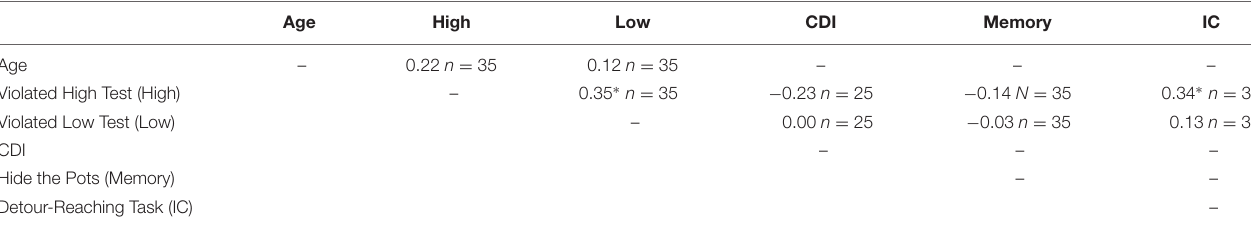
TABLE 6 | Zero-order correlations between age, performance on the inductive inference task, working memory and inhibitory control in the No Label Group only.